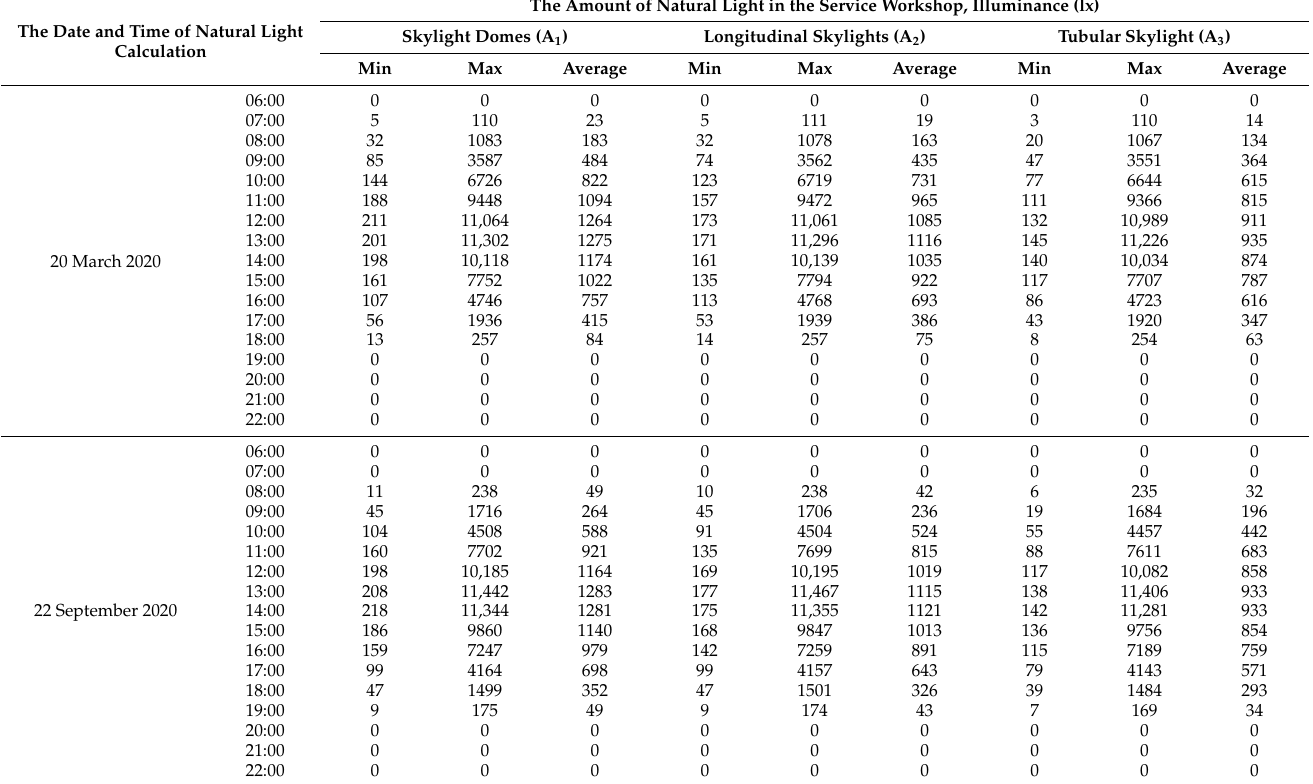
Table 17. The results of natural light calculation.